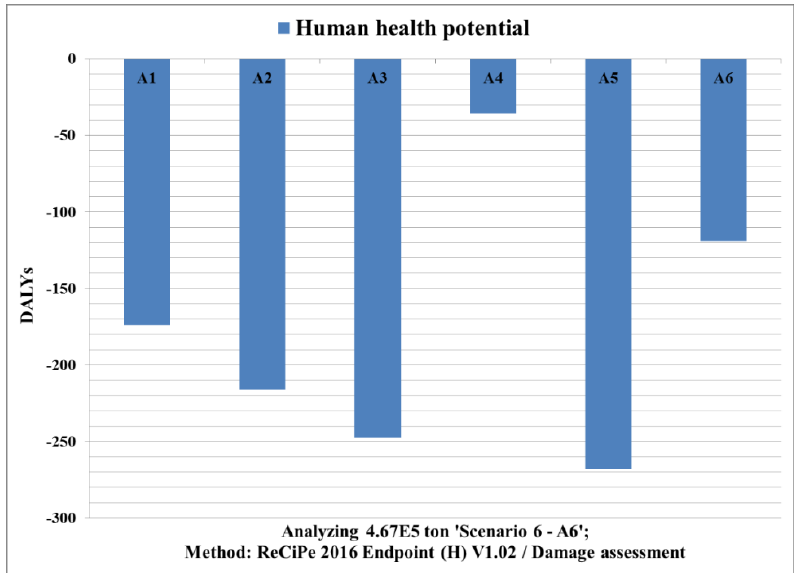
Figure 7. Human health impact potentials.